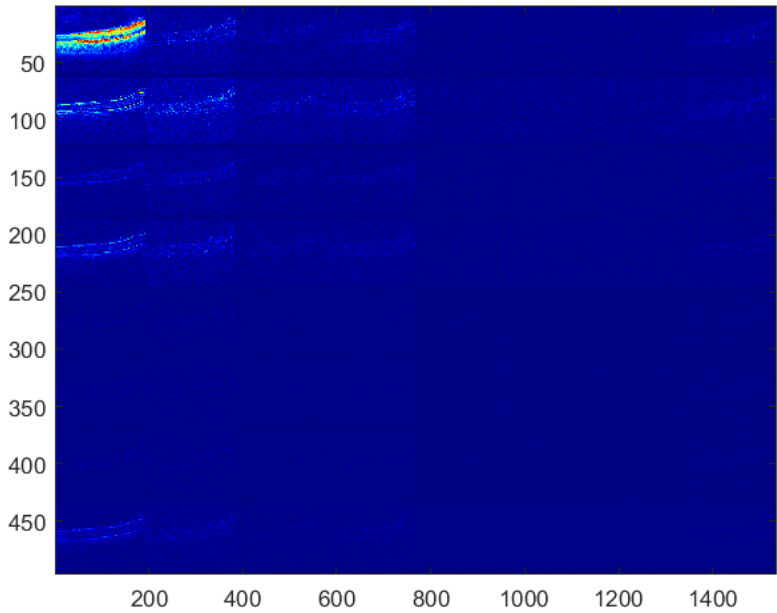
Figure 2. PHL spectrum coefficients grouped into